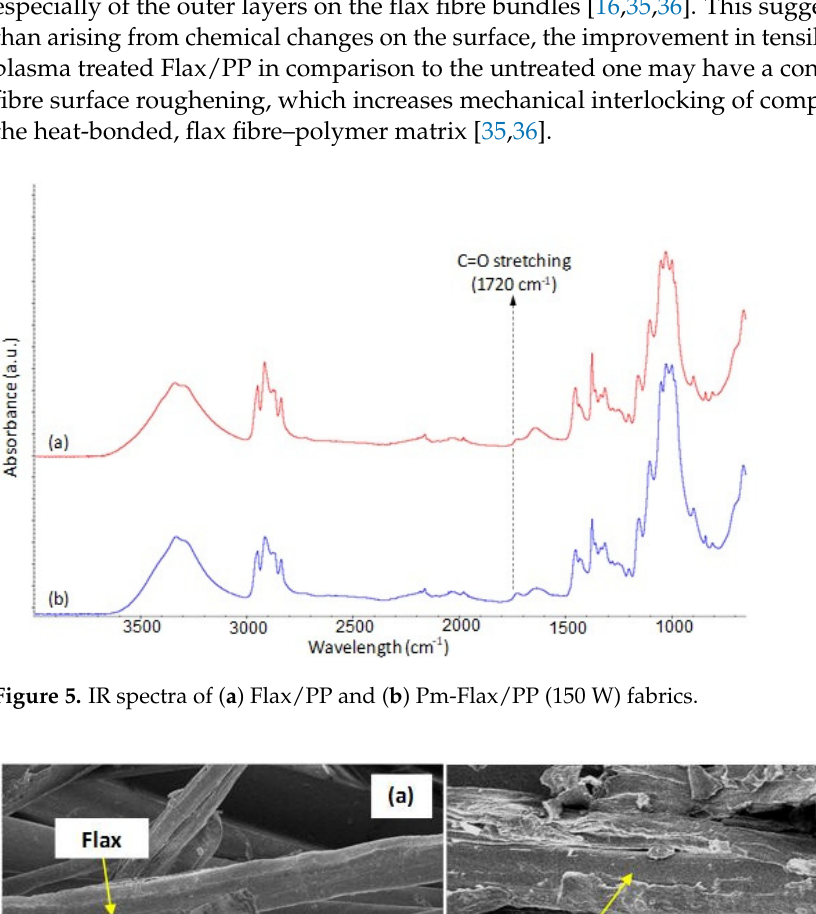
Figure 5. IR spectra of ( a ) Flax/PP and ( b ) Pm-Flax/PP (150 W) fabrics.